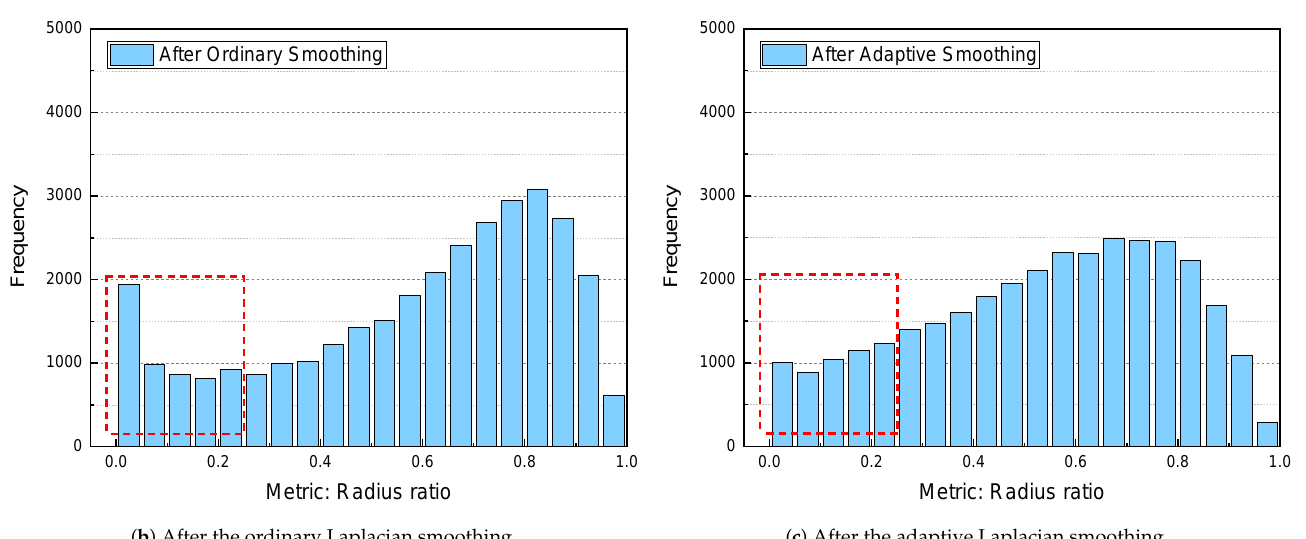
Figure 13. Statistical distribution of the tetrahedral mesh